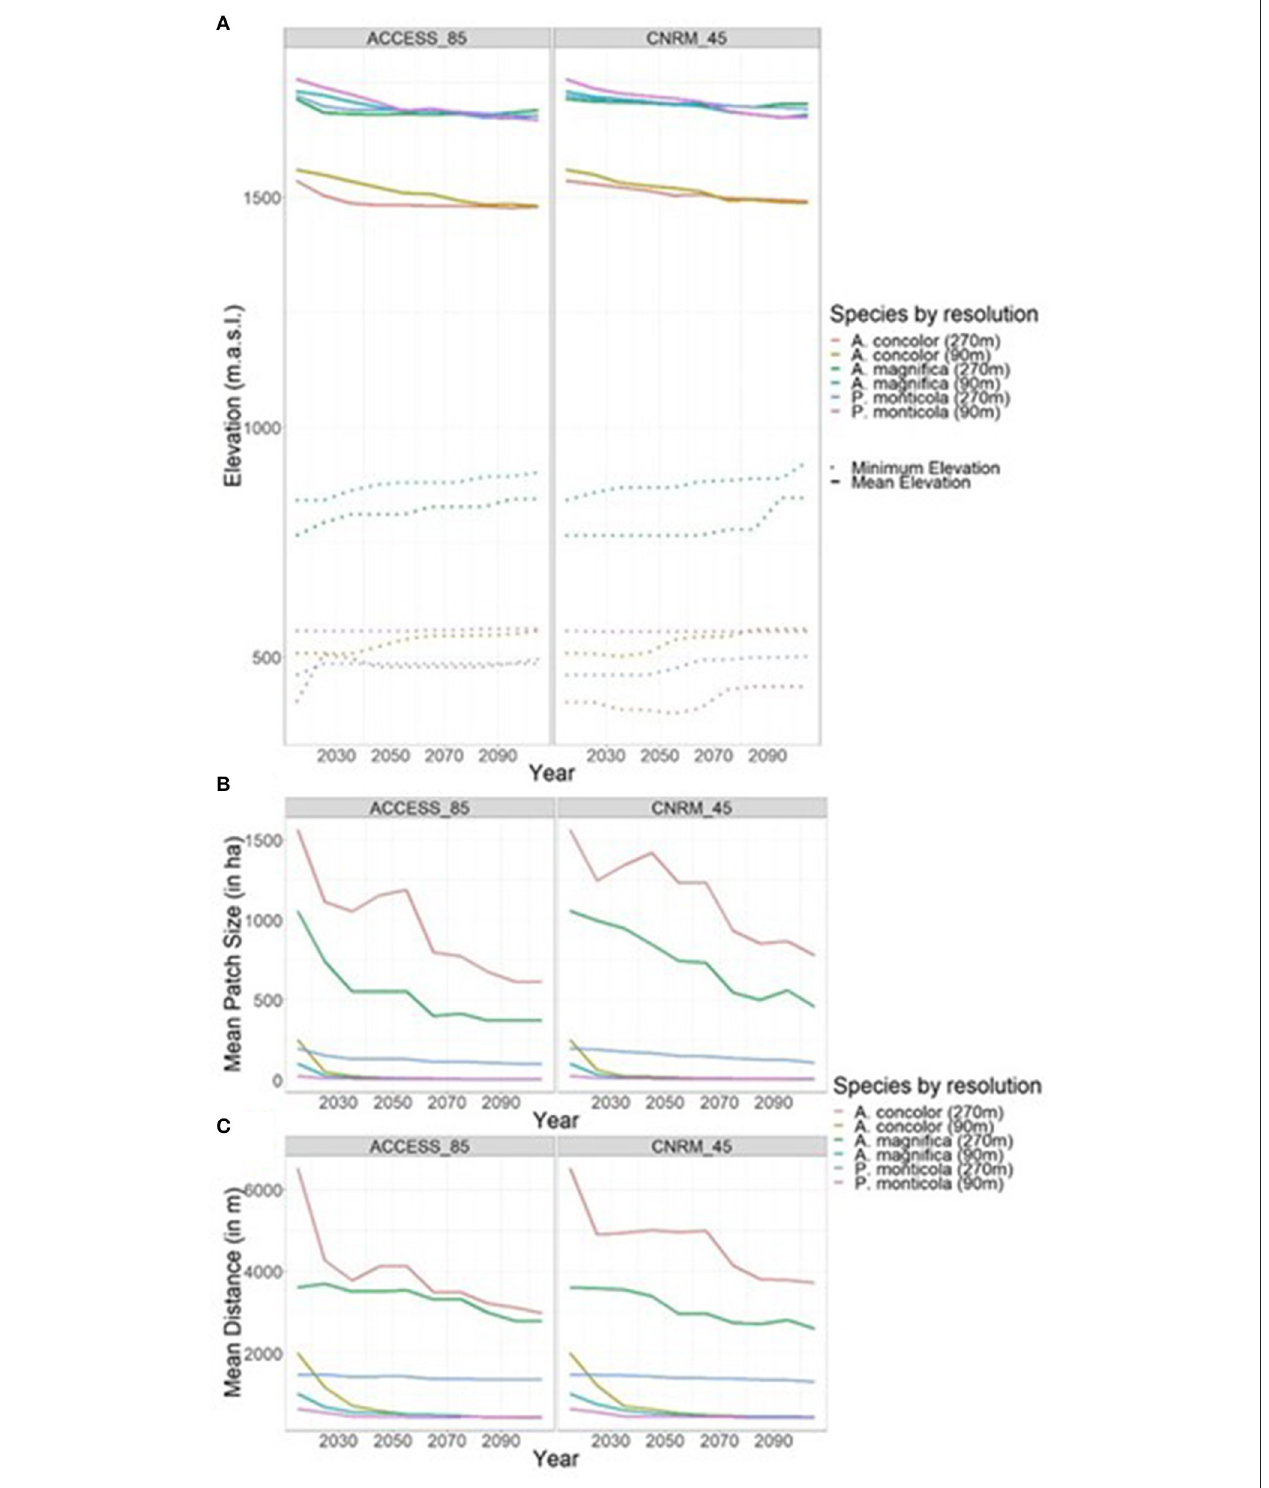
FIGURE 4 | Patch metrics of specific conifer species, under different model resolutions and different climate change projections. (A) Mean elevation (m.a.s.l.) of species (solid line) and minimum elevation of species (dotted line). Middle: mean patch size (in hectares). (B) Mean patch size (in hectares). (C) Mean distance between patches (in